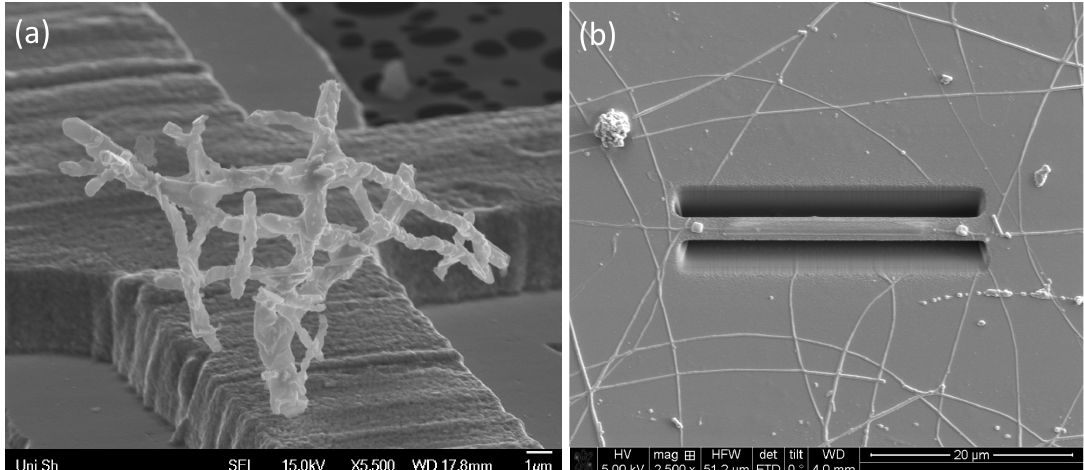
Figure 3. Two possibilities of handling the nanofiber mat pieces: ( a ) A broken-off section on a carbon-coated Cu-grid for transmission electron microscopy (TEM) imaging. This section maintains the interconnections between several nanowires. ( b ) Individual Bi-2212 nanowires on a silicon substrate. The nanowires adhere to the surface, so, e.g., FIB-cutting of sections becomes